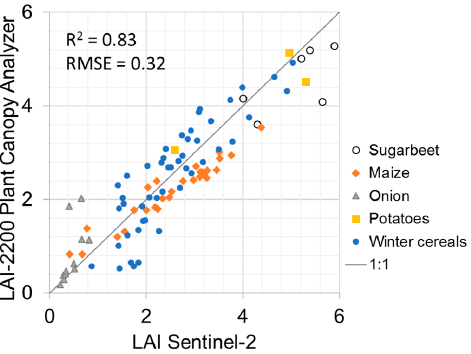
Figure 10. Scatterplot between ground and satellite-based LAI estimation for Marchfeld ( n = 95). The data were acquired from April to June 2016 and comprise six different Sentinel-2 scenes.